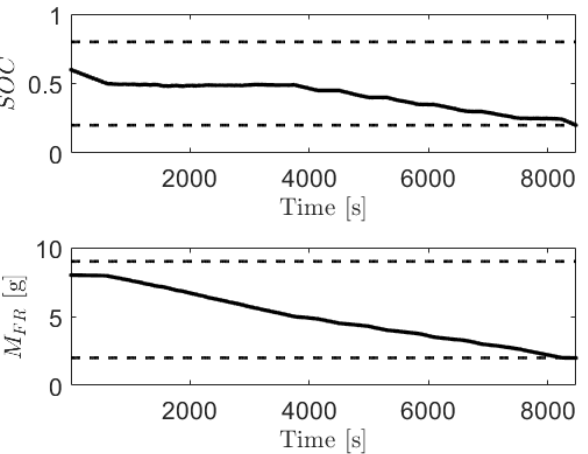
Figure 16. SOC and remaining M FR versus time, Simulation Scenario III; dashed lines show